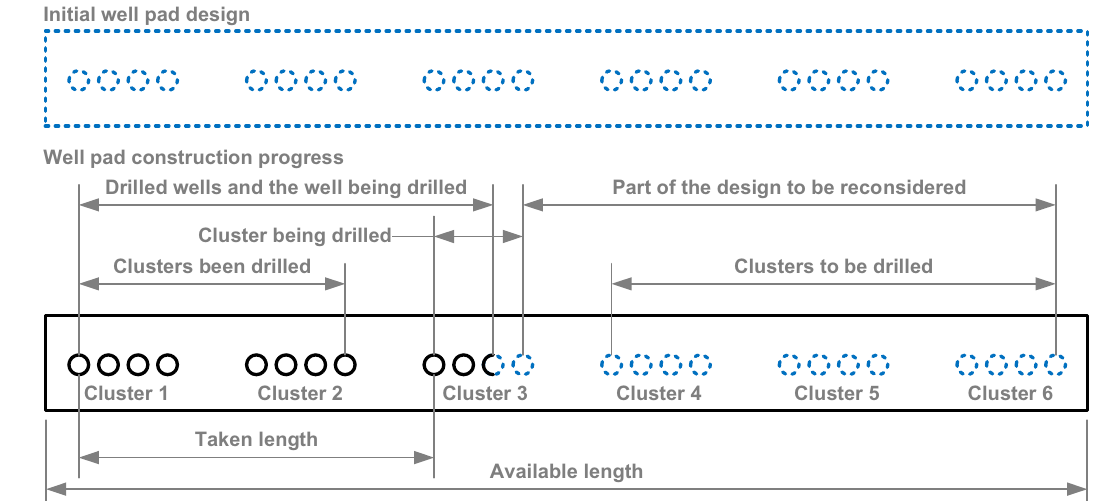
Fig. 1 Initial well pad design (top) and construction progress (bottom) up to the point of design reconsideration